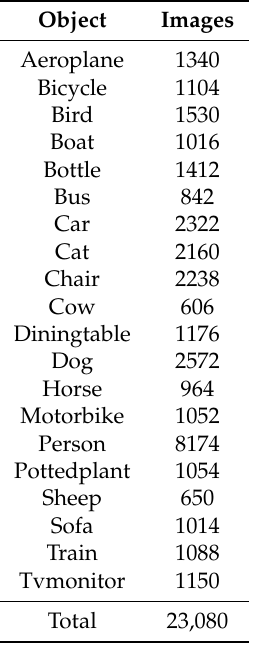
Table 2. Number of images for each category VOC2017 dataset.